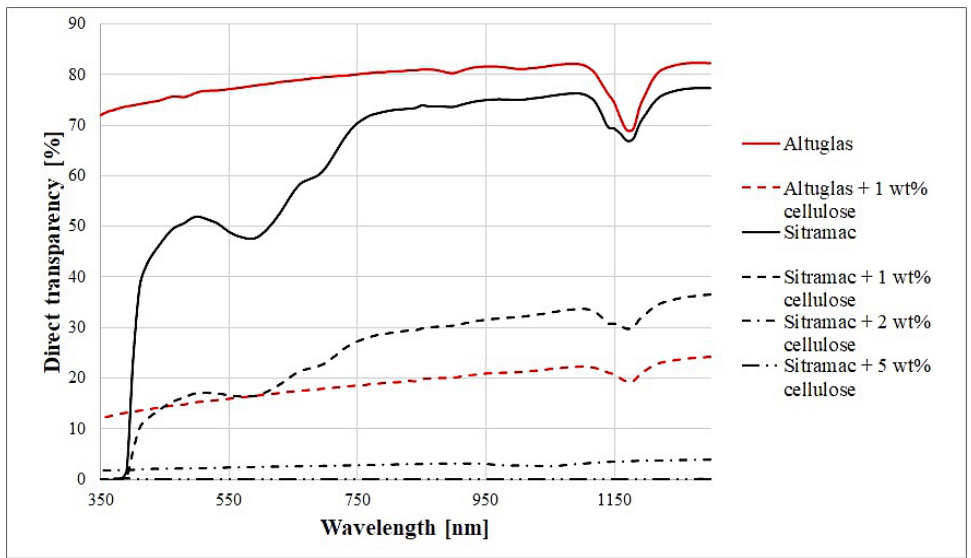
Figure 1. Direct transparency of unreinforced and reinforced PMMA specimens